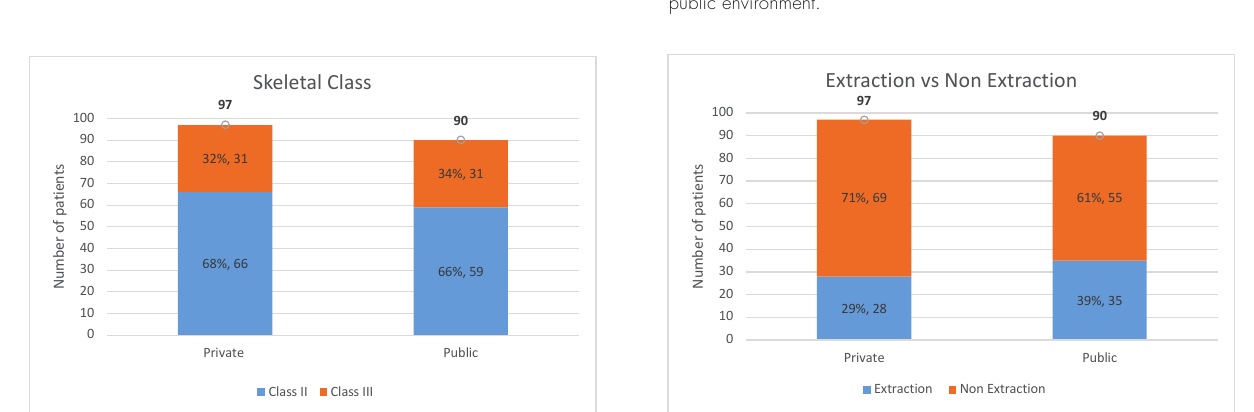
Figure 1. Demographic data. Figure 3. Treatment in the transverse dimension in private compared to public environment.